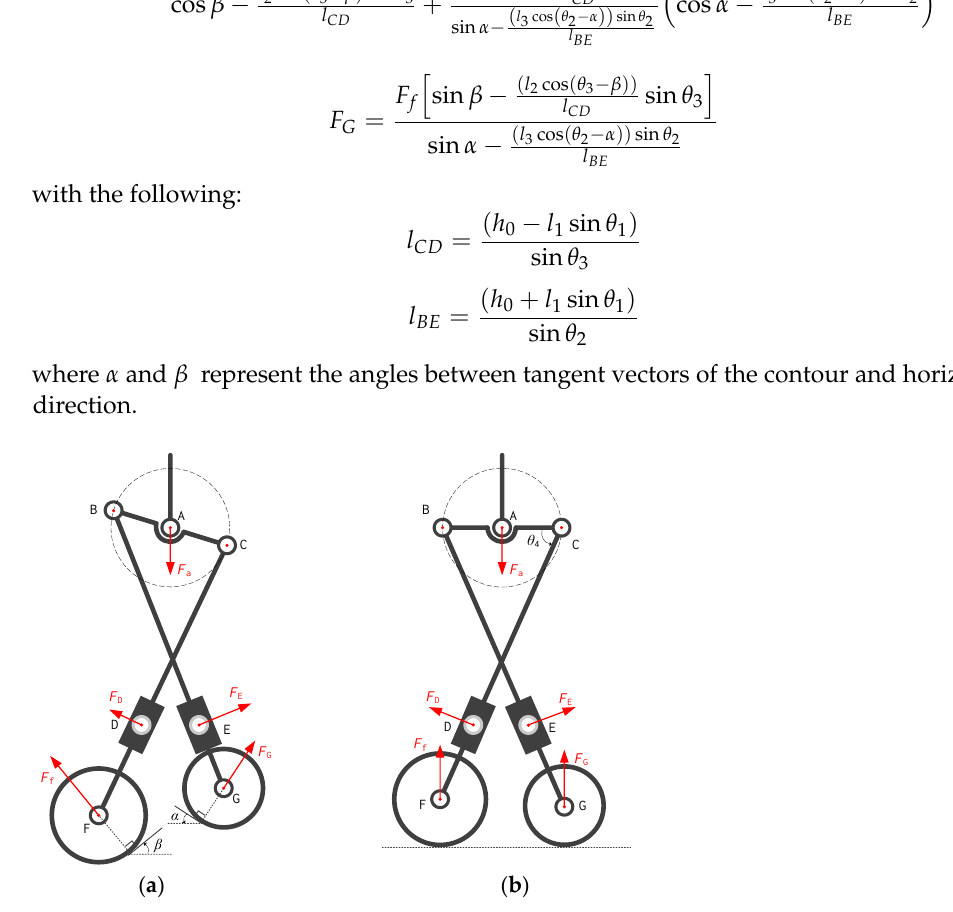
Figure 6. Schematic diagram of force distribution for the compaction mechanism conforming a surface in both ( a ) the compliant state and ( b ) the stiff state, illustrating the actuation force 𝐹 𝑎 , contact forces 𝐹 𝑓 and 𝐹 𝐺 , and the frame forces 𝐹 𝐷 and 𝐹 𝐸 .